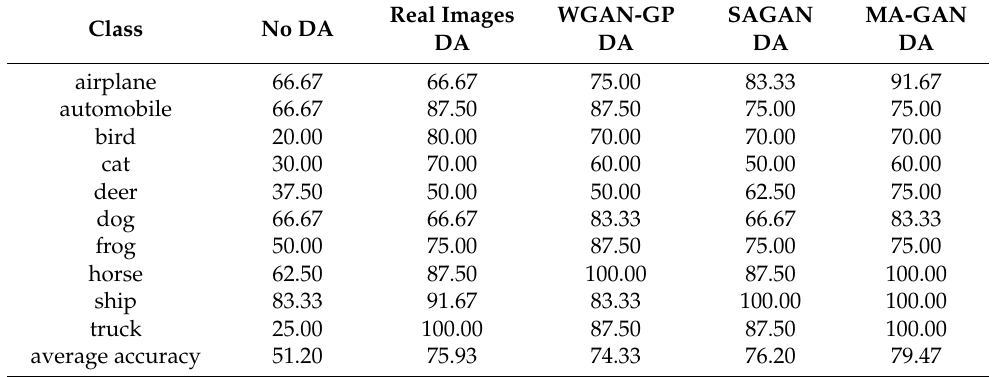
Table 13. Classified accuracy of CIFAR-10 training set after augmentation by different methods (%).